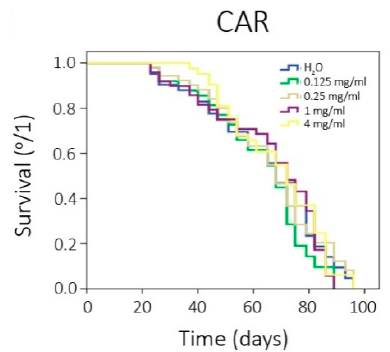
Figure 1. Survival curves obtained from log-rank test.